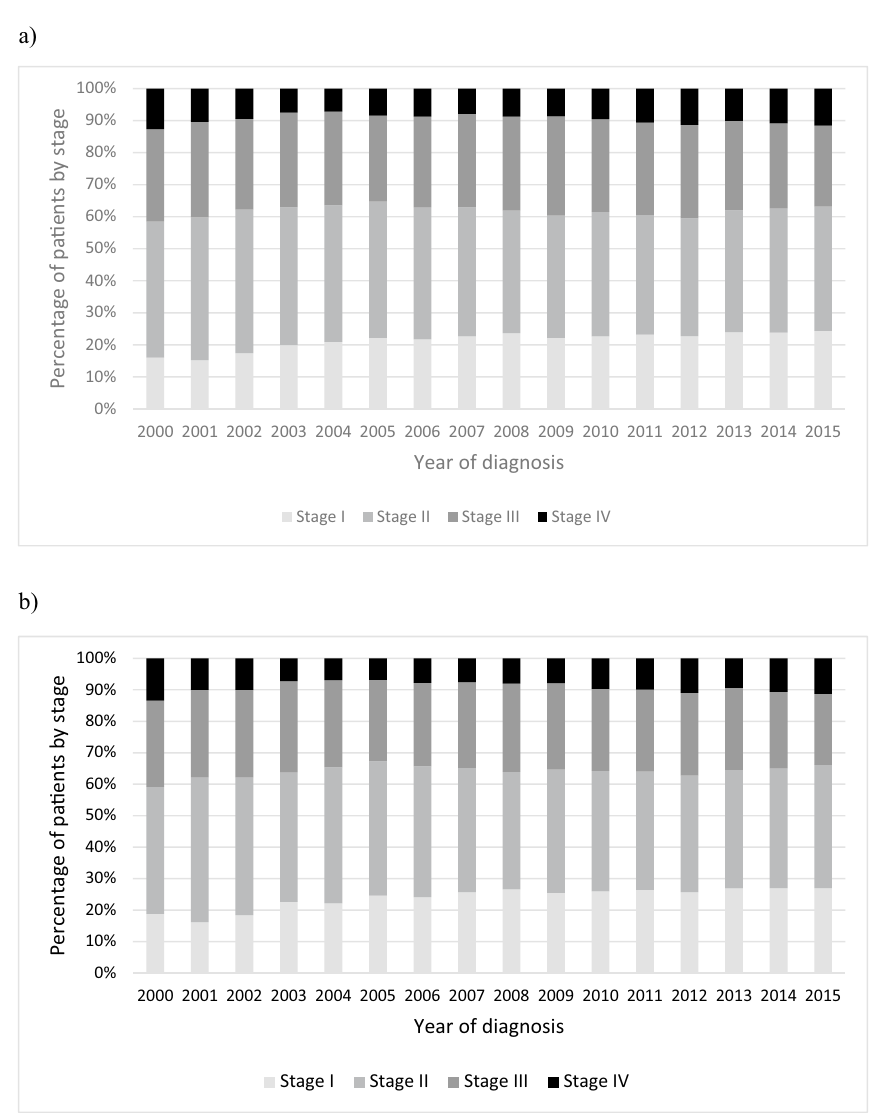
Figure 2. Percentage of clinical breast cancer stage at diagnosis by year of diagnosis. Cases included in the hospital-based cancer registries affiliated to the public health system in the state of Sao Paulo, Brazil. ( a ) All subjects; ( b ) screening-exposed population (50–69